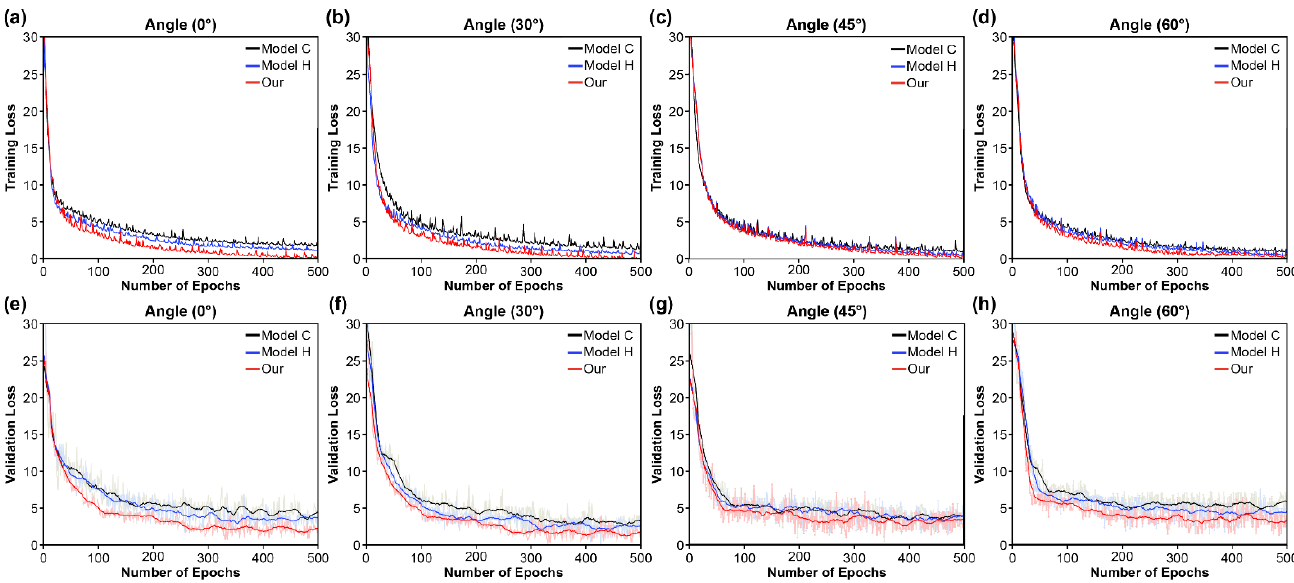
Figure 7. Training and validation loss comparing convergence speed of transcription layers (Model C, Model H, and the proposed model). ( a – d ) Training loss at ( a ) 0°; ( b ) 30°; ( c ) 45°; ( d ) 60°; ( e – h ) Validation loss at ( e ) 0°; ( f ) 30°; ( g ) 45°; ( h ) 60°. Table 2. Performance of the proposed model compared to various models on the OuluVS2 dataset.